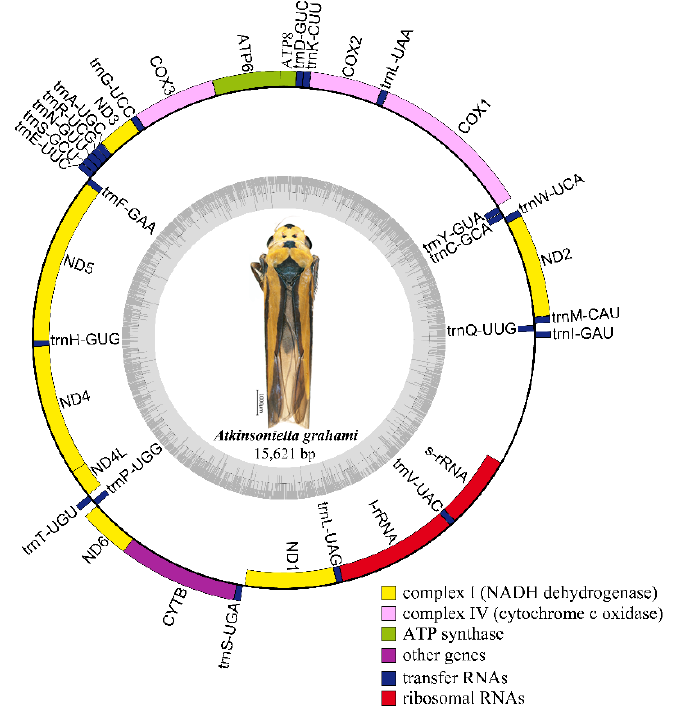
Figure 1. Circular map of the mitochondrial genome of Atkinsoniella grahami. Genes are represented by different color blocks. Color blocks outside the circle indicate that the genes are on the majority strand (J-strand); those within the circle indicate the genes are located on the minority strand (N-strand).